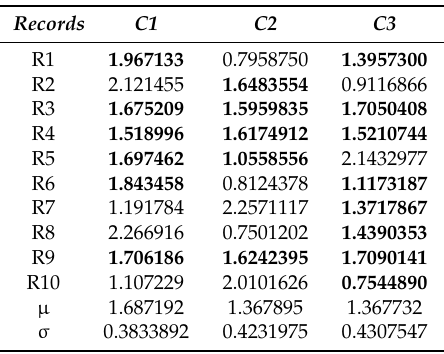
Table 5. Distance of records from centroid. Bold numbers denote in-pattern records which are in range of one standard deviation from the mean.